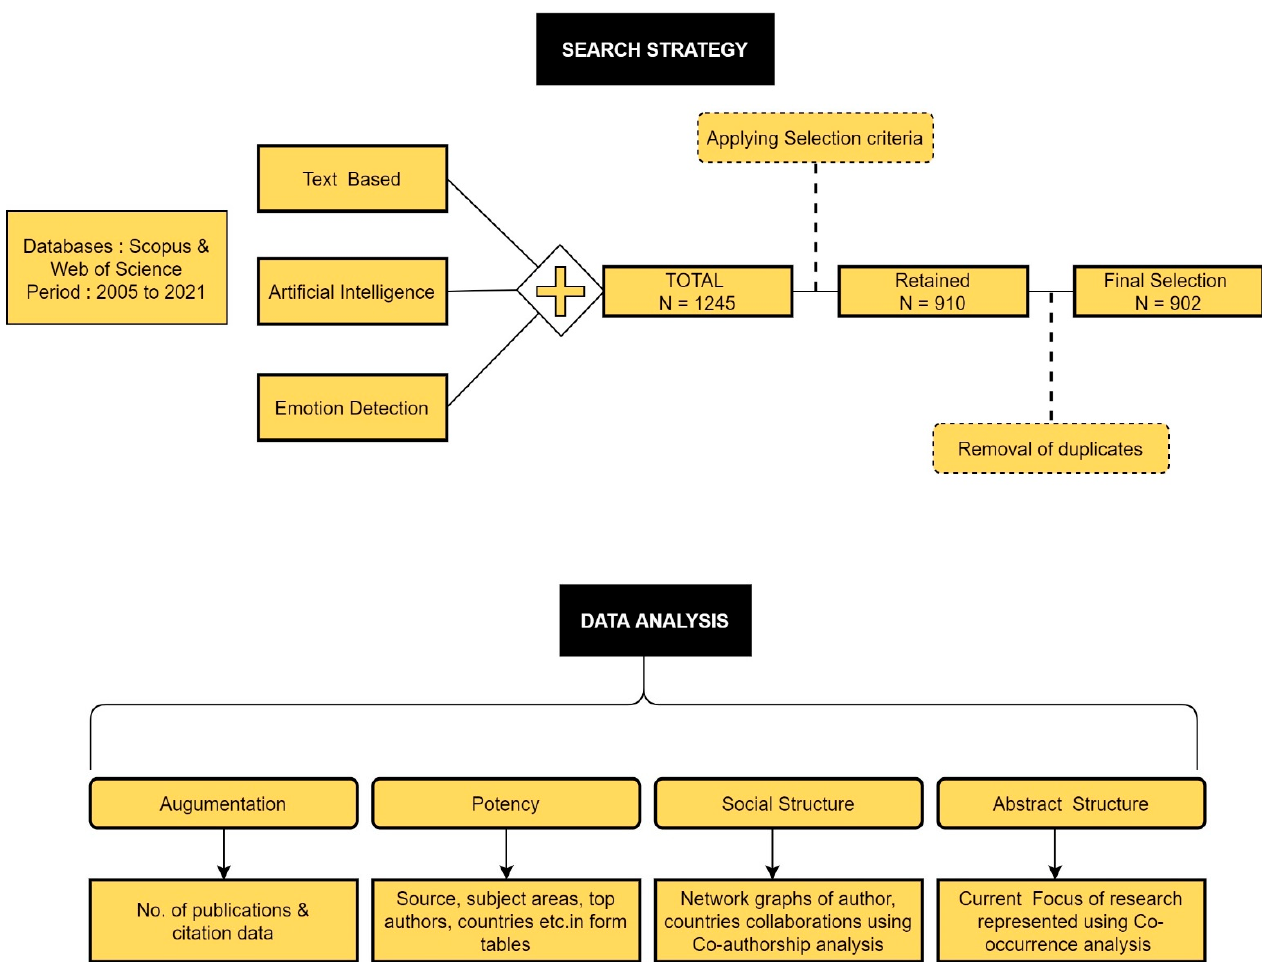
Figure 4. Methodological Outline.